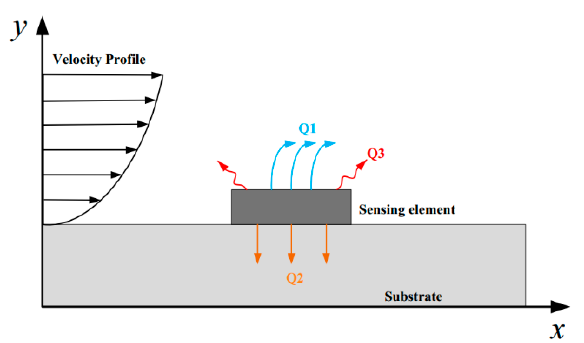
Figure 1. Schematic view of the hot-film sensor working principle.